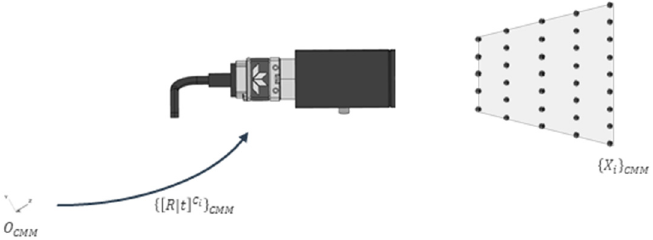
Figure 6. The camera calibration process consists of defining a geometry of 3D coordinates { X i } defined in O CMM reference system to compute the intrinsic (K) and extrinsic parameters { [ R | t ] C } of each C camera also defined in the O CMM .